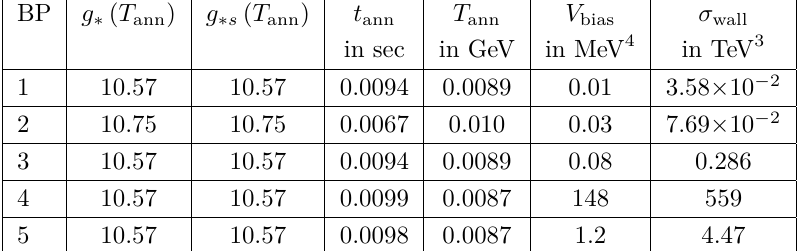
Table 2. The values of the parameters used for the estimation of the GW intensity from the annihilation of domain walls for the chosen five BPs (BP 1–5). All the calculations are done using C ann =5, A =0.8, (cid:15) GW =0.7. See text for details.